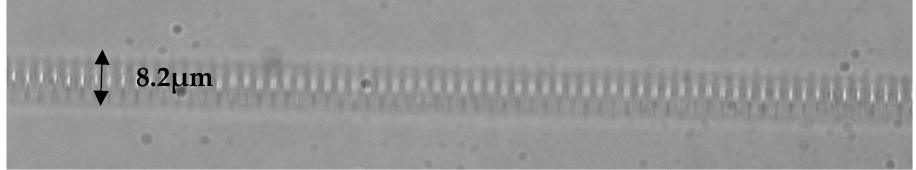
Figure 3. Microscope picture of the refractive index modifications induced using the PlbPl femtosecond laser inscription method.